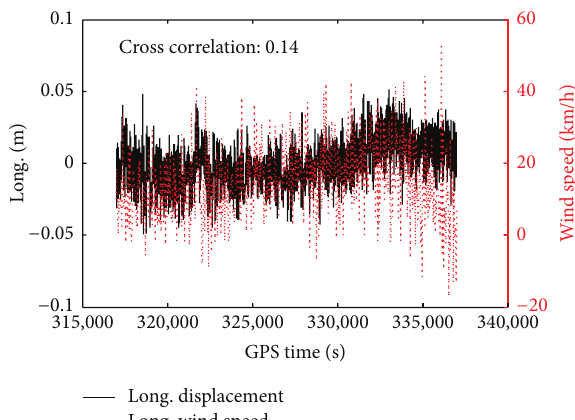
Figure 17: Longitudinal displacement and wind speed.